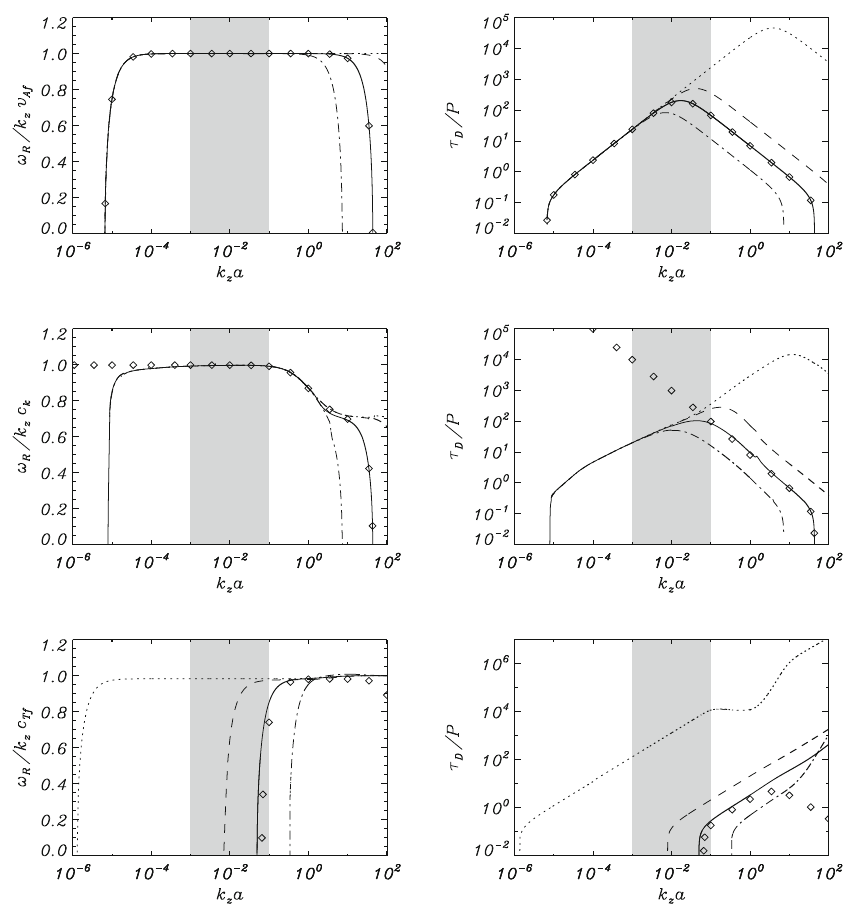
Fig. 66 Wave damping by ion-neutral effects in an infinitely long prominence thread. Dimensionless phase speed (left panels) and ratio of the damping time to the period (right panels) as a function of k z a for Alfvén waves (top panels), kink waves (middle panels) and slow waves (bottom panels). The different linestyles represent different ionisation degrees: ˜ μ p = 0 . 5 (dotted), ˜ μ p = 0 . 6 (dashed), ˜ μ p = 0 . 8 (solid) and ˜ μ p = 0 . 95 (dash-dotted). Symbols are the approximate solution given by Equation (36) in Soler et al. (2009b) for ˜ μ p = 0 . 8. The shaded zones correspond to the range of typically observed wavelengths of prominence oscillations. The Alfvén speed in the thread, v Af , the kink speed, c k , and the cusp speed in the thread, c Tp , have been used to compute the dimensionless phase speed. Image reproduced with permission from Soler et al. (2009b), copyright by